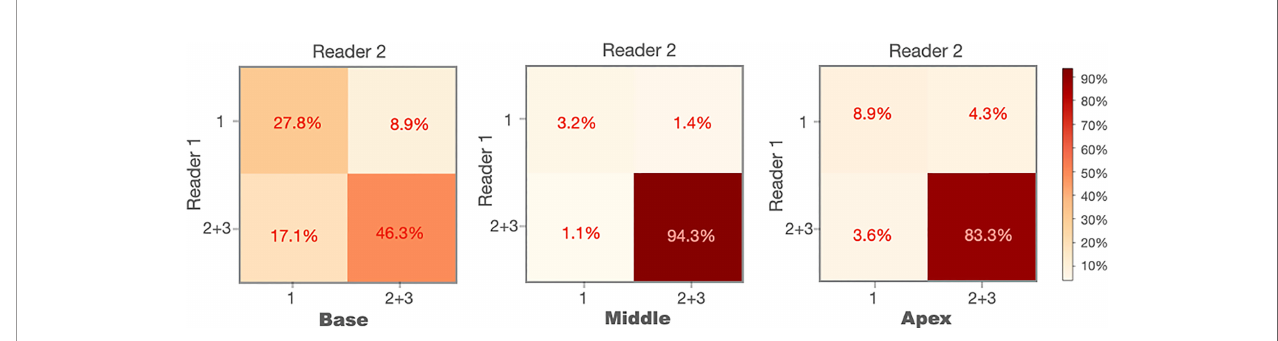
FIGURE 4 | Confusion matrices of the prostate base, midgland, and apex for the cases without excellent segmentation (n = 281).